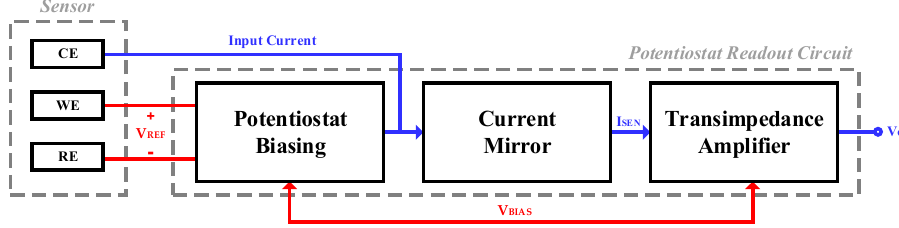
Figure 2. Block diagram of the proposed potentiostat readout circuit.